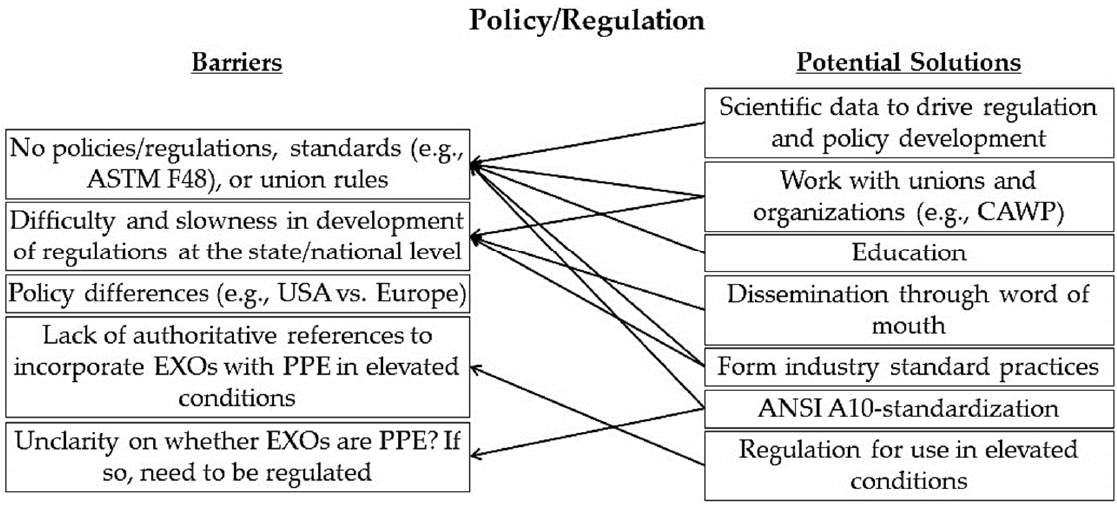
Figure 5. Mapping of potential solutions to identified barriers in the policy/regulation category.